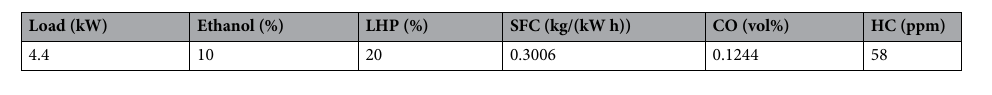
Table 8. Response Optimization results of SFC, CO, and